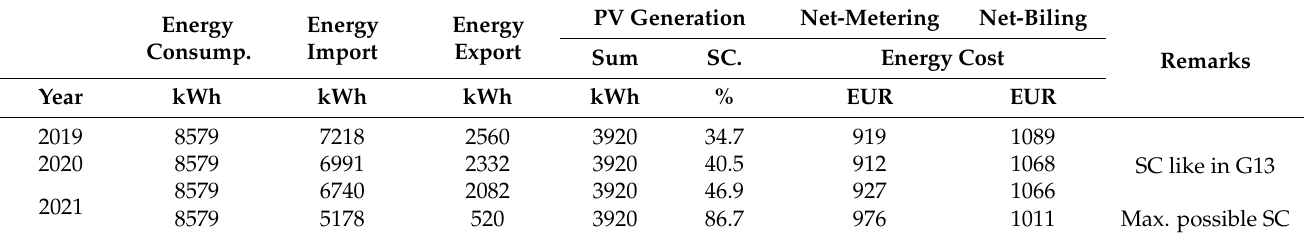
Table 11. Hypothetical energy in tariff G11 cost before and after introducing the HEMS and the ESSS. Energy